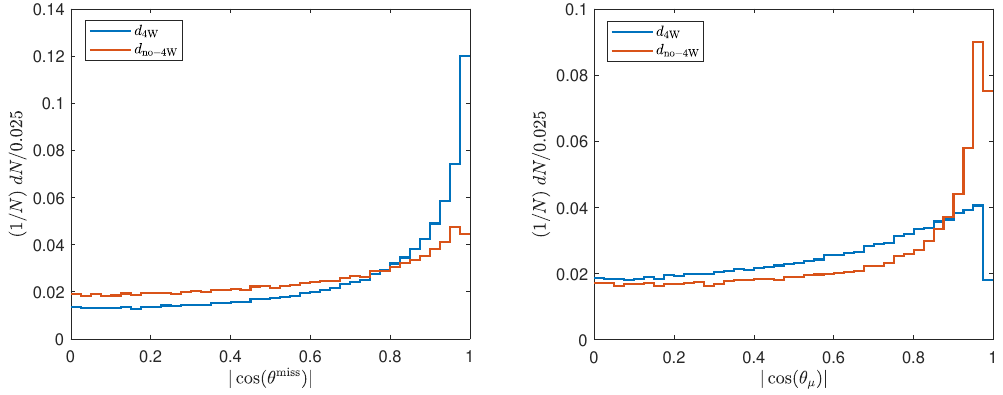
Figure 2 . The normalized distributions of | cos( θ miss ) | (left panel) and | cos( θ µ ) | (right panel). For the process µ + µ − → ν ¯ ν W + W − , the (anti-)neutrinos tend to be along the muon µ µ beam direction and are back-to-back. Meanwhile, when ˆ s is large, W ± are energetic